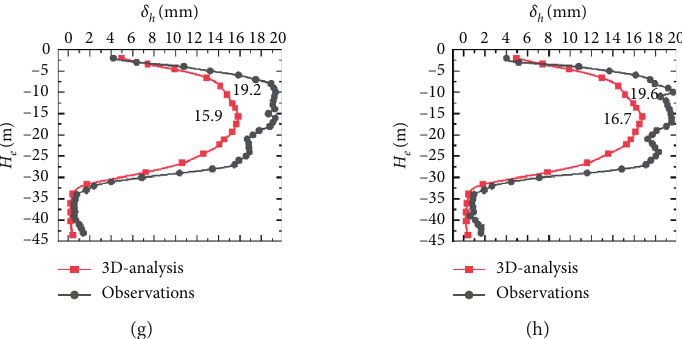
Figure 11: Lateral wall deflection curve under various working conditions for YDM project. (a) Step 1, (b) step 2, (c) step 3, (d) step 4, (e) step 5, (f) step 6, (g) step 7, and (h) step 8.